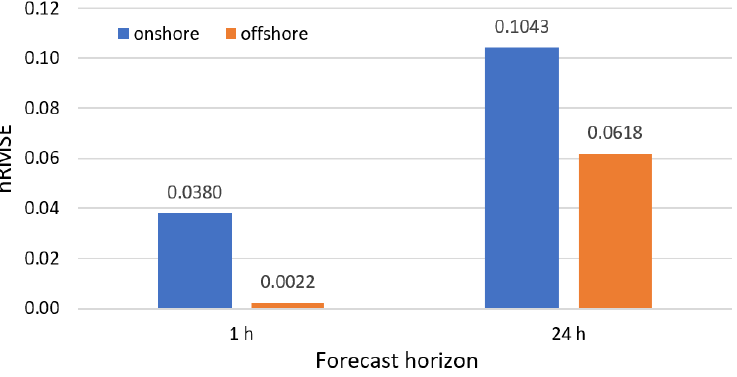
Figure 21. Magnitude of nRMSEs depending on farm location and forecasting horizon.